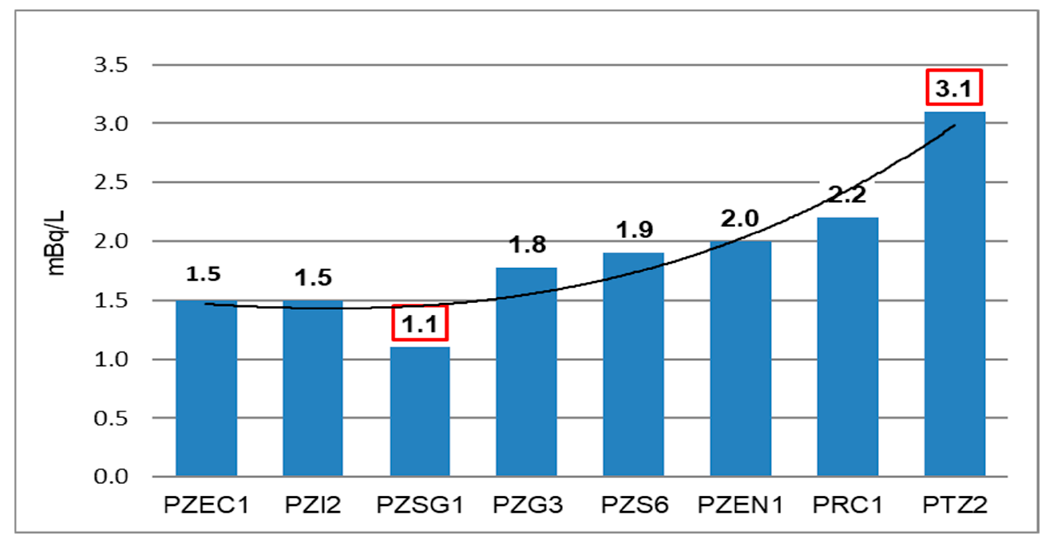
16 of 22 Figure 12. Graph of Total and Isotopic Uranium Concentration in Monitored Piezometers (Median Values) [6].